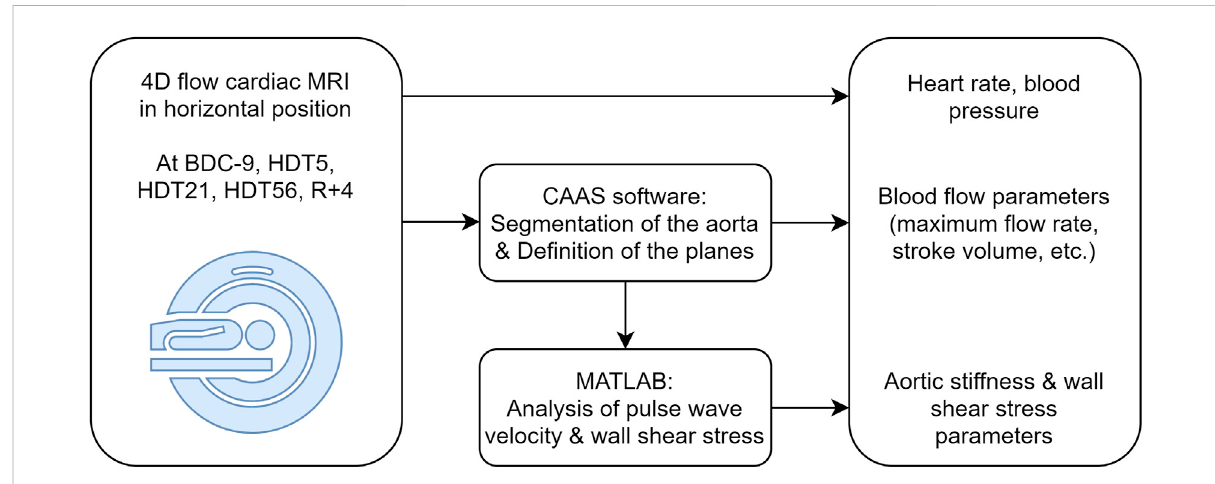
FIGURE 1 Experimental and analysis procedure. BDC: baseline data collection, HDT: head-down tilt, R: recovery.